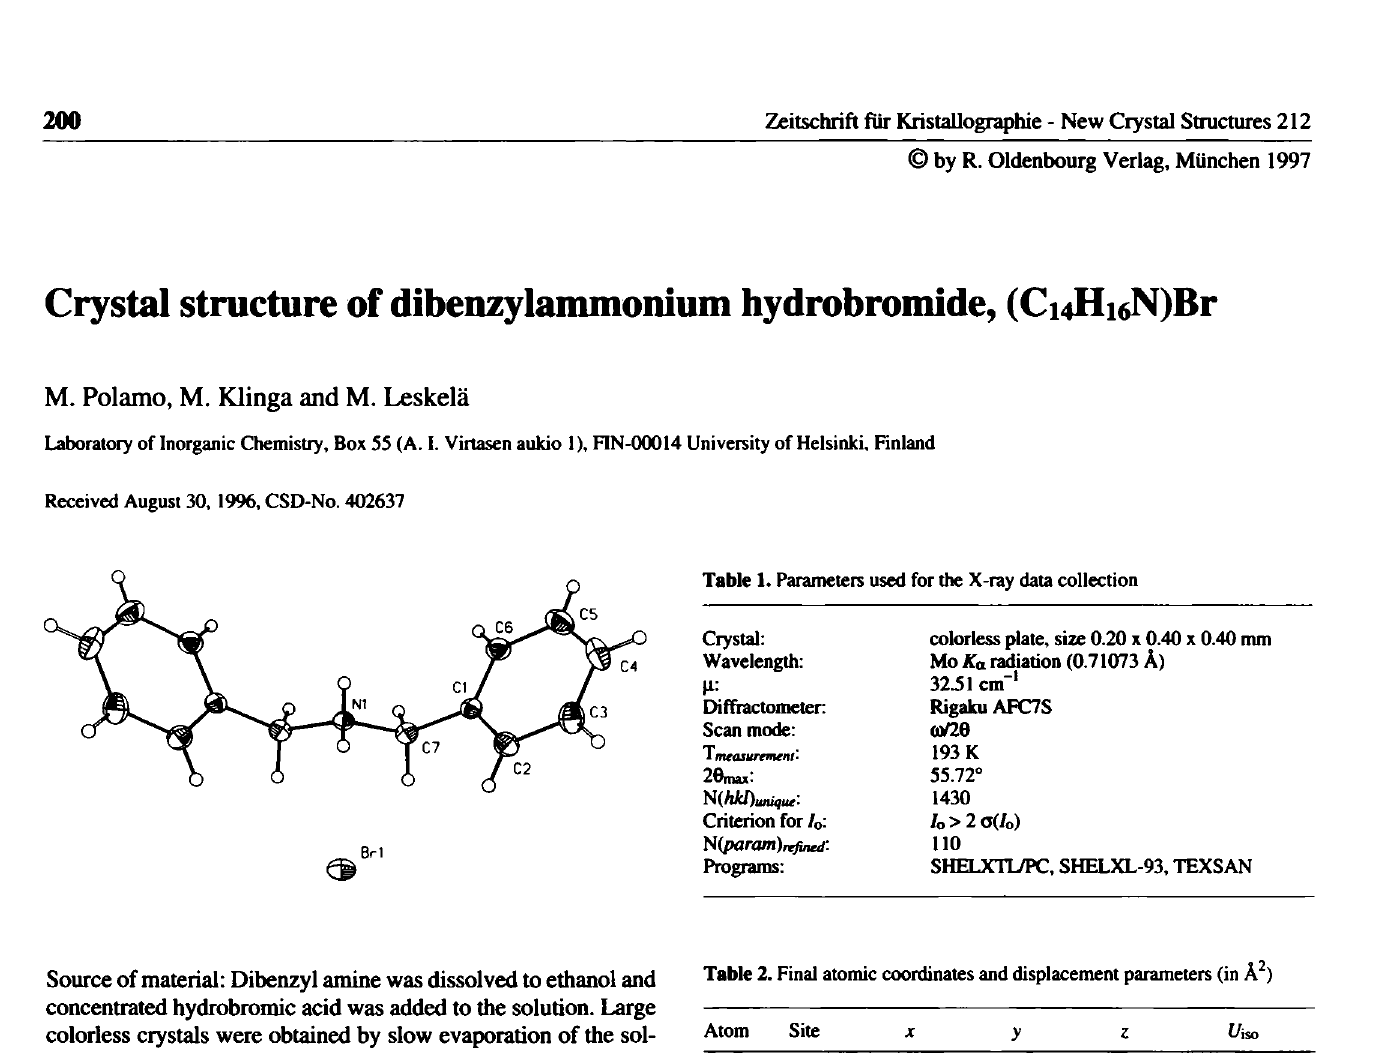
Table 2. Final atomic coordinates and displacement parameters (in Â 2 )